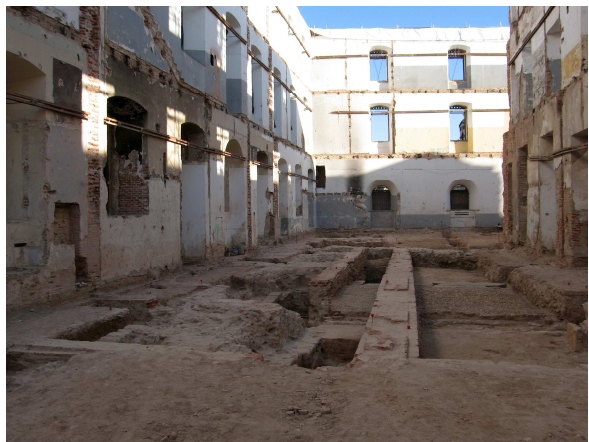
Figure 10. View of the archaeological excavation.